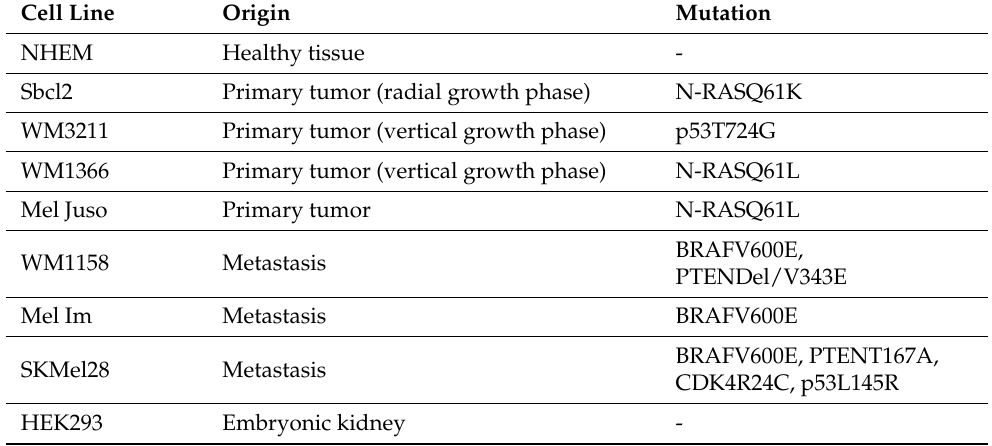
Table 1. Overview of used cell lines.